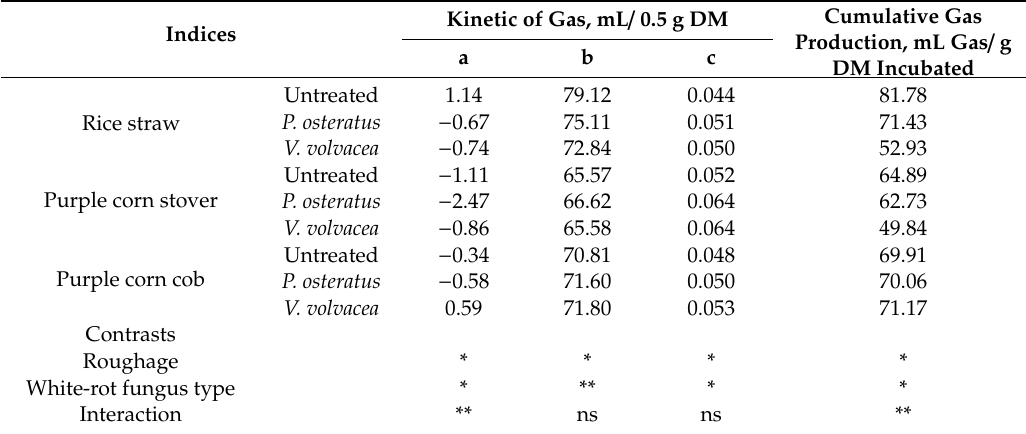
Table 3. E ff ect of roughage fermentation with white-rot fungi on gas kinetic kinetics and cumulative gas production after 96 h of